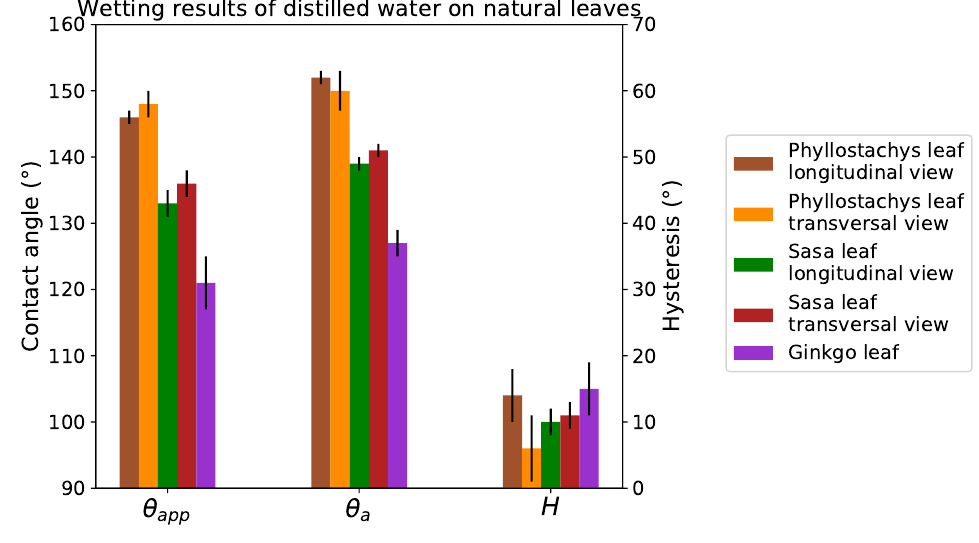
Figure 9. Wetting results on